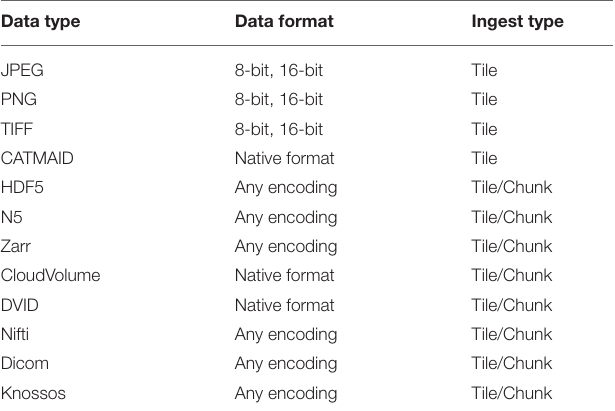
TABLE 1 | Data types and associated data formats that are supported by tile and chunk/volumetric based ingest service